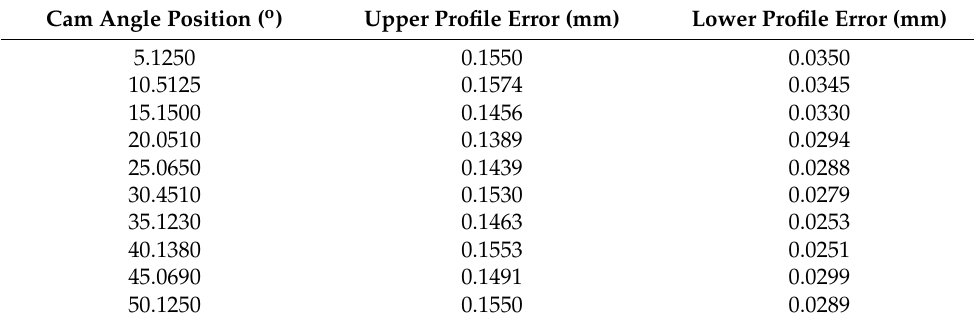
Table 4. The error evaluation result of the indexing segment 1.